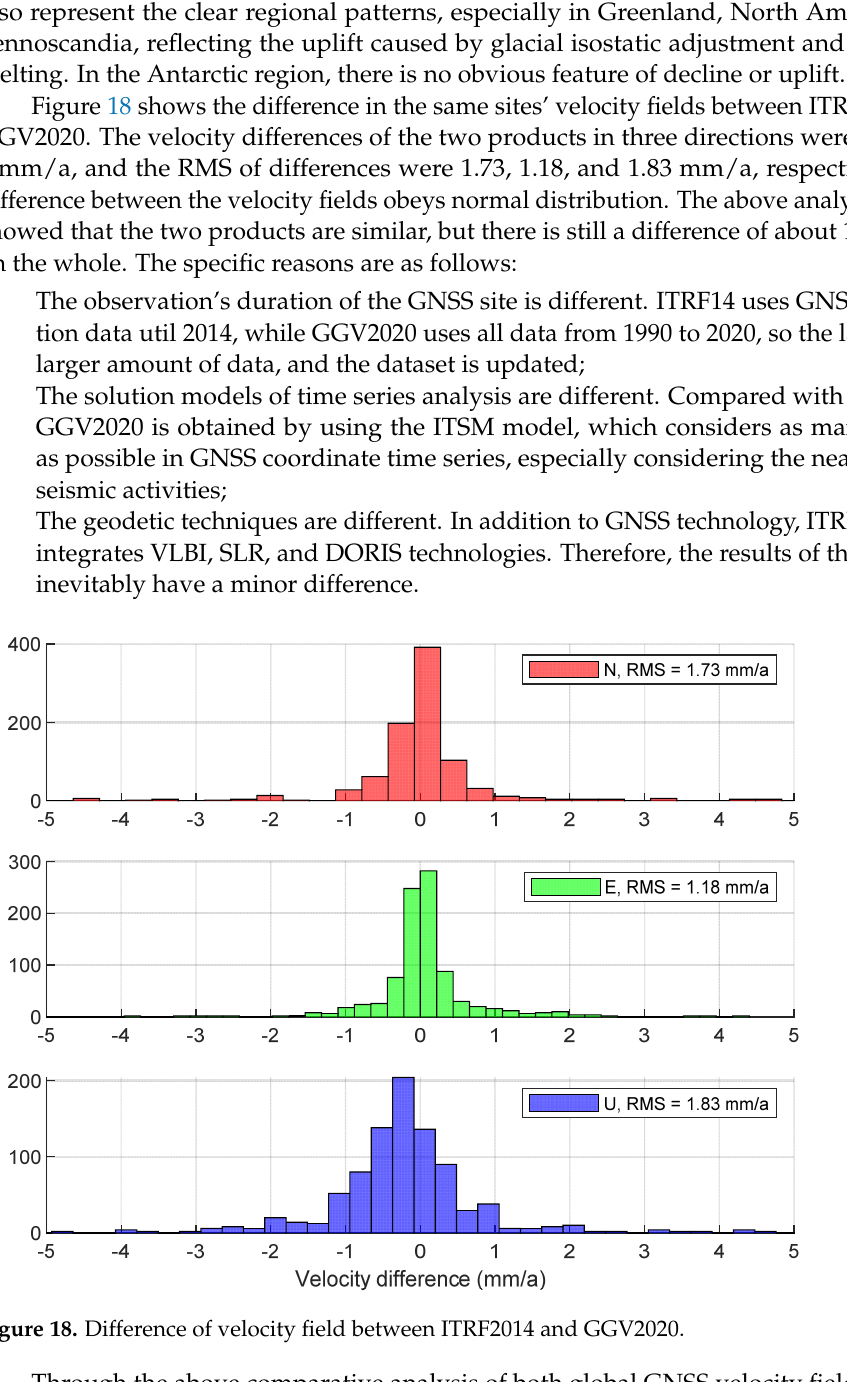
Figure 17. Comparison of the ITRF2014 and GGV2020 global GNSS velocity fields. ( a ) ITRF2014 horizontal velocity field; ( b ) ITRF2014 vertical velocity field; ( c ) GGV2020 horizontal velocity field; ( d ) GGV2020 vertical velocity field; (e) ITRF14 and GGV2020 horizontal merging velocity field; ( f ) ITRF14 and GGV2020 vertical merging velocity field.